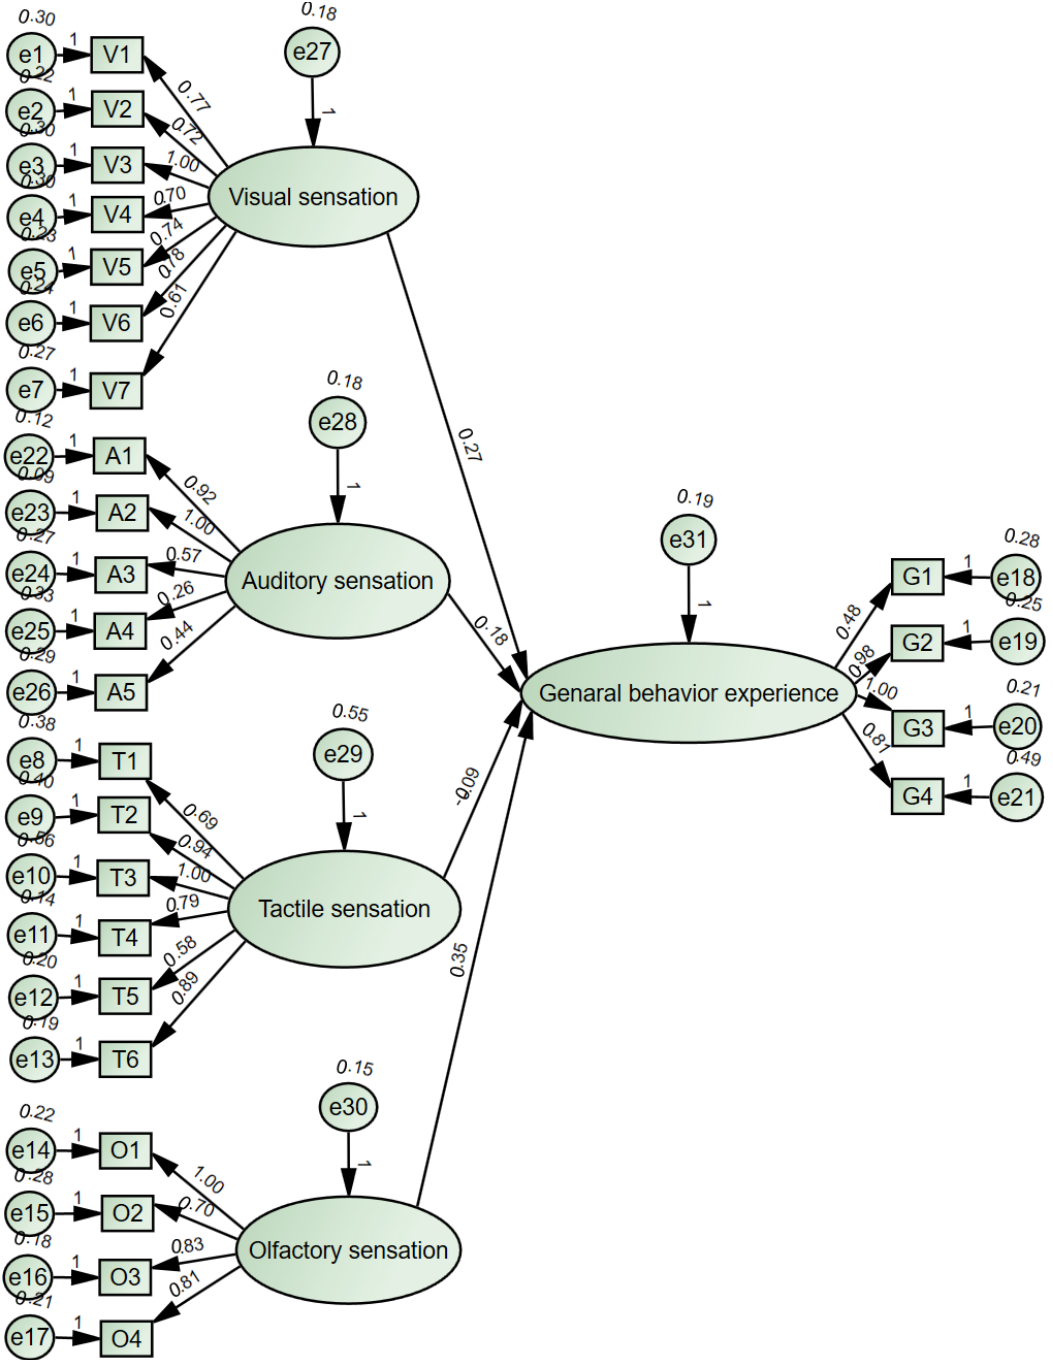
Figure 3. Structural equation model regression coefficients.